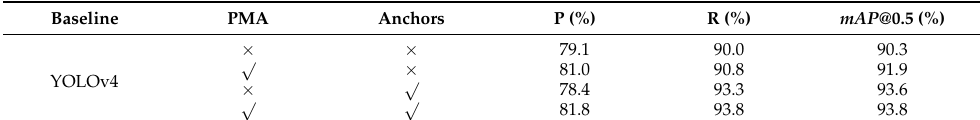
Table 7. Detection results from adding different modules to YOLOv4.